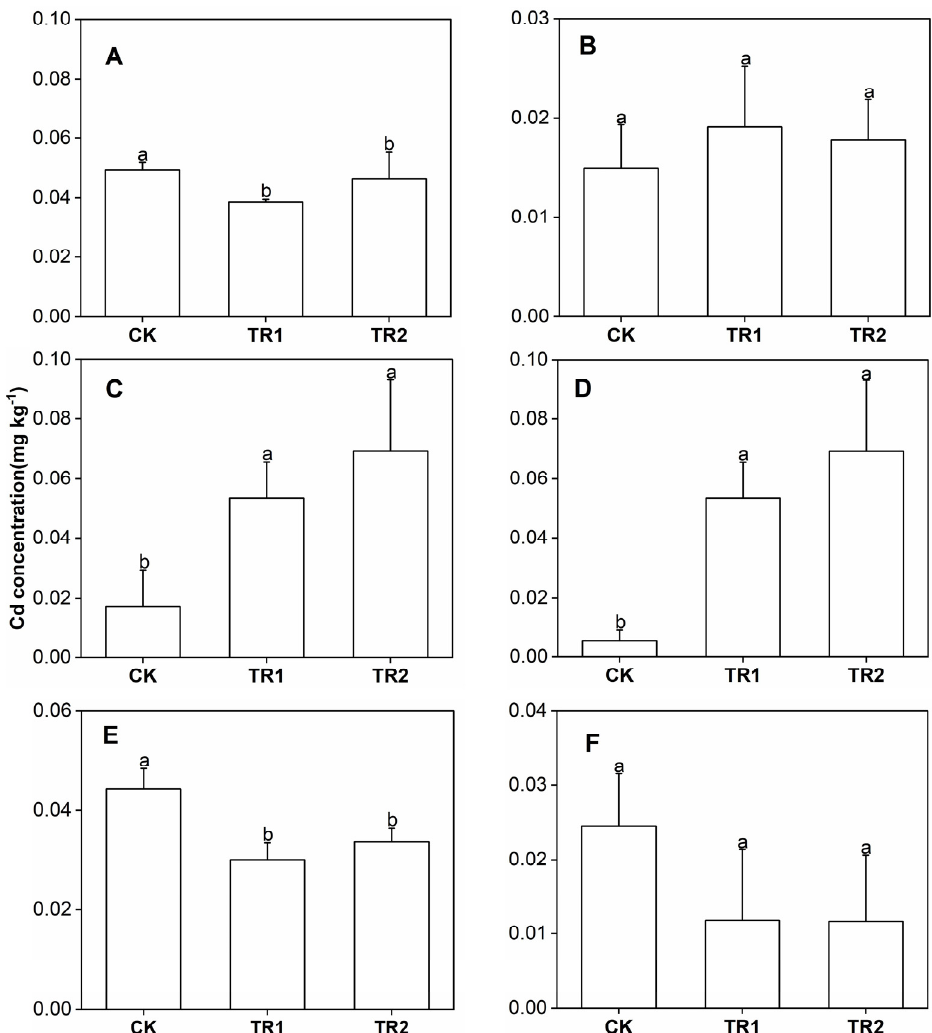
Figure 8. Fruit Cd concentration. ( A ) First period intercropping papaya, ( B ) Second period intercropping papaya, ( C ) First period intercropping grapefruit, ( D ) Second period intercropping grapefruit, ( E ) First period intercropping fig, ( F ) Second period intercropping fig. The different letters above the column indicate the significant differences among different treatments at p < 0.05.